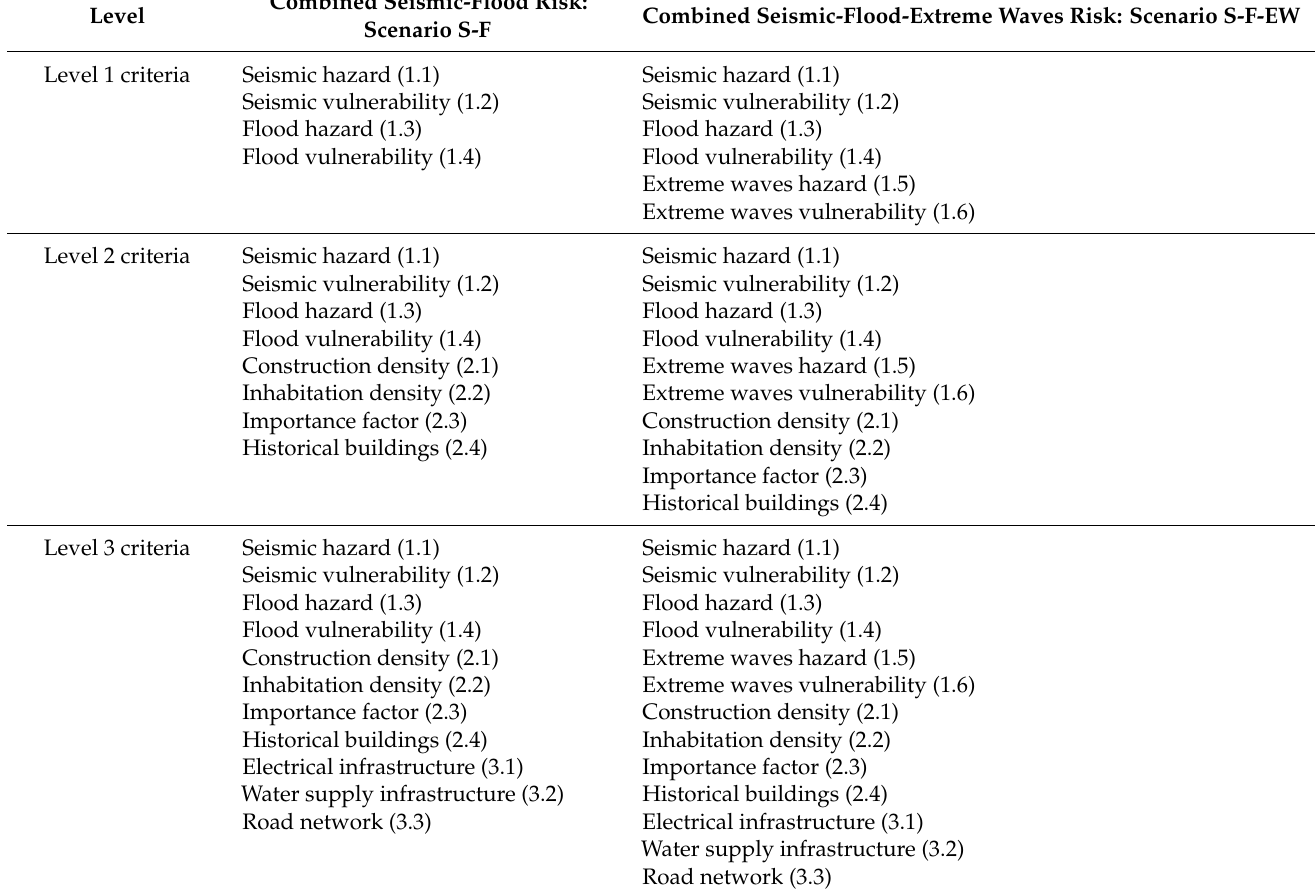
Table 3. Combined risks analysis and criteria for each level of